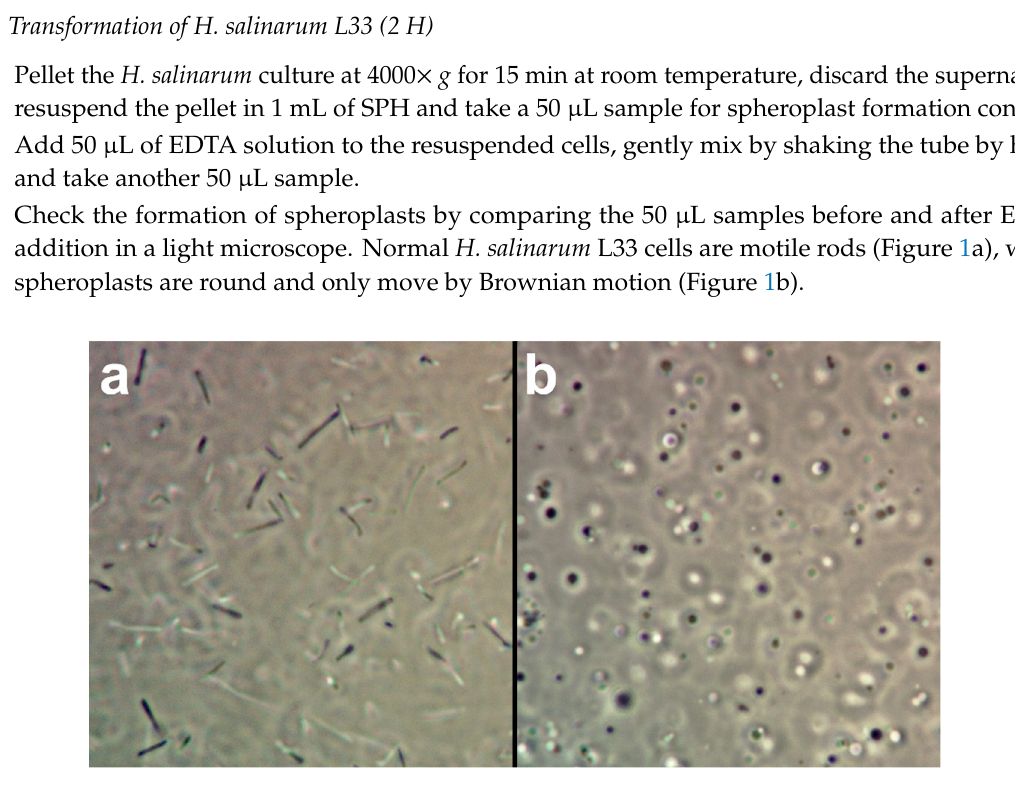
Figure 1. H. salinarum L33 cells as rods and spheroplasts. Micrographs of H. salinarum L33 cells before ( a ) and after supplementation of ethylenediaminetetraacetic acid (EDTA) to a final concentration of 25 mM ( b ). ( a ) Before the addition of EDTA, the cells are motile rods up to a length of 6 µm. Rarely, mitotic cells with spherical shape can be found. ( b ) After the addition of EDTA, the archaeal cell envelope, the S-layer, is decomposed and all cells adopt a spherical shape in which they are deprived of autonomous motion. Shown are excerpts of 50 × 50 µm.